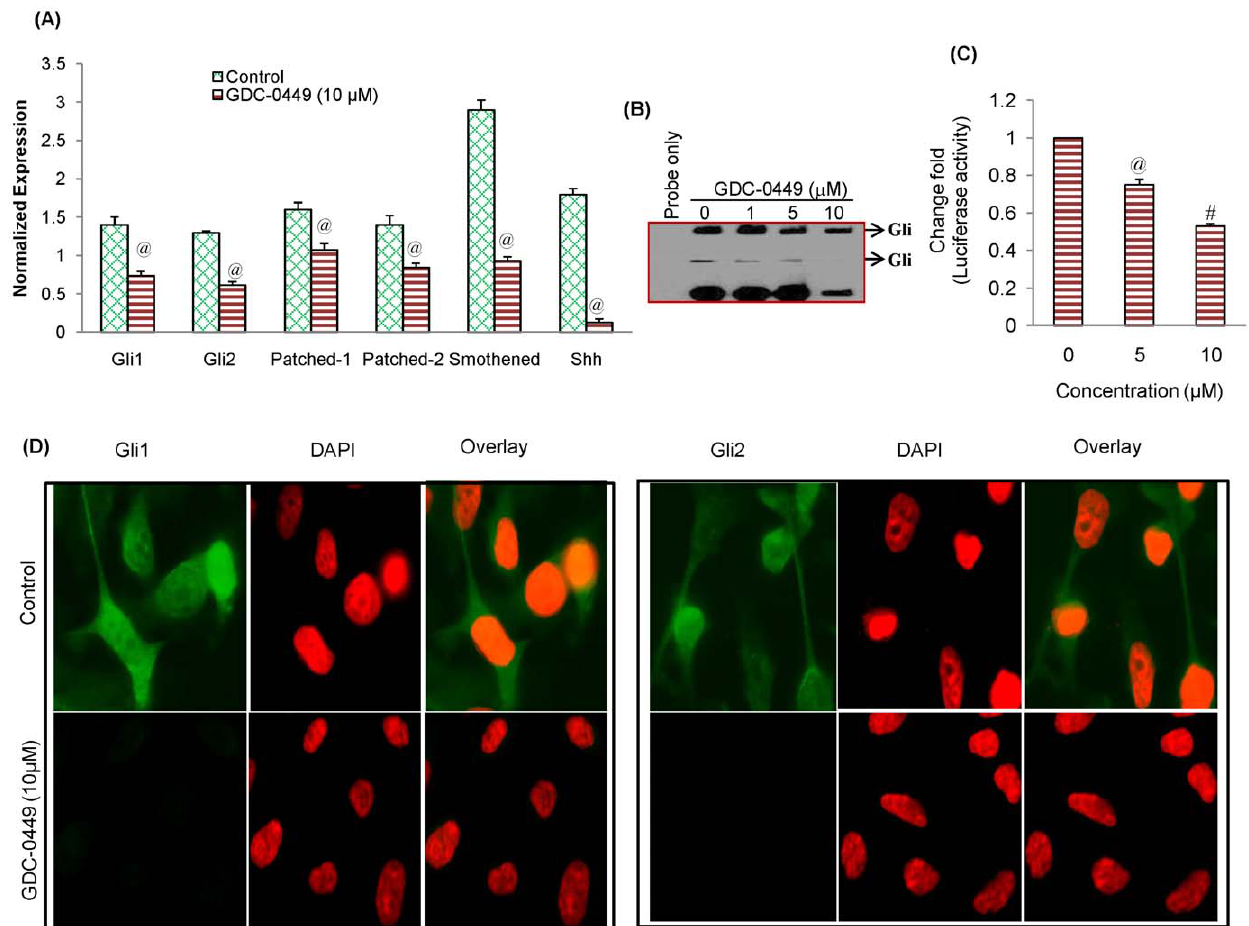
Figure 5. GDC-0449 downregulates the expression of various components of SHH signaling pathway in pancreatic CSCs . (A), Pancreatic CSCs were treated with GDC-0449 (10 m M) for 36 h. At the end of incubation period, RNA was extracted and the expression of Gli1, Gli2, Patched-1, Patched-2, Smoothened and Shh was measured by qRT-PCR. Data represent the mean 6 SD. @ significantly different from respective control (P , 0.05). (B), Pancreatic CSCs were treated with and GDC-0449 (0, 1, 5 and 10 m M) for 48 h. Nuclear extracts were prepared and the gelshift experiment was performed. Probe only, control (without GDC-0449), and GDC-0449 treated samples (1, 5 and 10 m M), respectively. The data are representative of three experiments. (C), Gli-dependent luciferase activity is reduced by GDC-0499. Pancreatic CSCs were transduced with lentiviral construct expressing Gli-dependent luciferase reporter, and treated with GDC-0449 (0, 5 and 10 m M) for 48 h. Lysates were prepared, and luciferase activity was measured. Normalized luciferase activity is presented as mean 6 SD. @ or # significantly different from respective control (P , 0.05). (D), GDC-0449 inhibits expression of Gli1 and Gli2 in human pancreatic CSCs. The cells were seeded on fibronectin-coated coverslips and treated with GDC-0449 (10 m M) for 48 h. Subsequently, cells were fixed with 4% paraformaldehyde, blocked in 10% normal goat serum and stained with Gli1 and Gli2 primary antibodies (1:100) for 16 h at 4 u C and washed with PBS. Afterwards, cells were incubated with fluorescently labeled secondary antibody (1:200) along with DAPI (1 mg/ml) for 1 h at room temperature and cells were mounted and visualized under a fluorescent microscope. For better visuality, the color of DAPI was changed from blue to red.